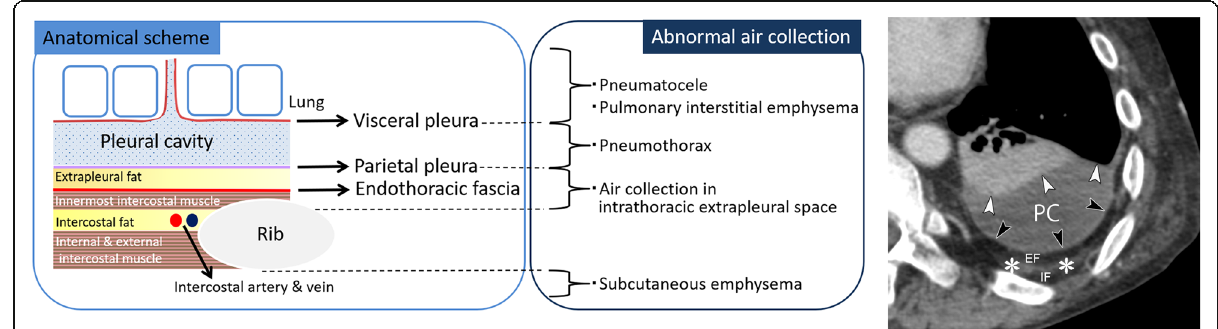
Fig. 1 Anatomical scheme of the pleural cavity and the chest wall and disease of abnormal air collection in each anatomical space. Axial chest CT of a 50-year-old man with chronic empyema shows fluid collection in the pleural cavity and thickened pleura. The CT shows the visceral pleura (white arrowheads), pleural cavity (PC), parietal pleura (black arrowheads), extrapleural fat (EF), innermost intercostal muscle and endothoracic fascia (white asterisks), and intercostal fat (IF). The innermost intercostal muscle is normally defective in the dorsal mediastinal side of the chest